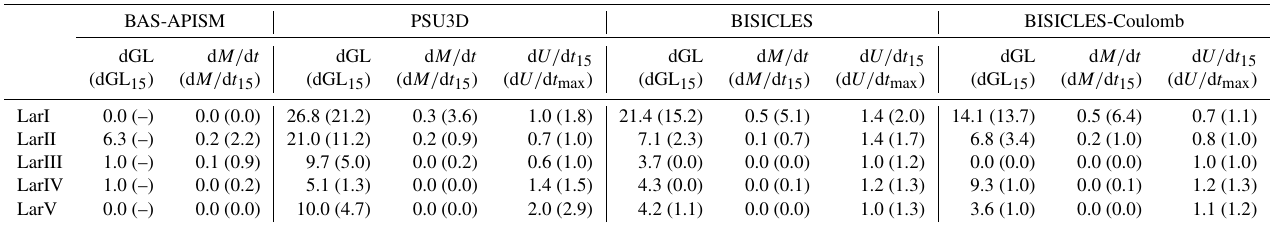
Table A1. Maximum grounding-line retreat (dGL, km), mass change rate (d M/ d t , Gta − 1 ) and speed-up (d U/ d t 15 ) for selected sample basins in Larsen C embayment for Experiment 1 (immediate collapse). Subscript indicates that numbers are averaged over 15 years after ice-shelf collapse, with the exception of dGL 15 , which is the sum over this period. For columns without subscript the numbers are for the entire 300-year simulation period. For speed-up, in addition to the average number over 15 years (d U/ d t 15 ), the maximum speed-up in this time period is provided (d U/ d t max ). Speed up was calculated for a region within 5km of the current grounding line. As BAS-APISM does not simulate the ice shelf, speed-up calculations were not carried out.